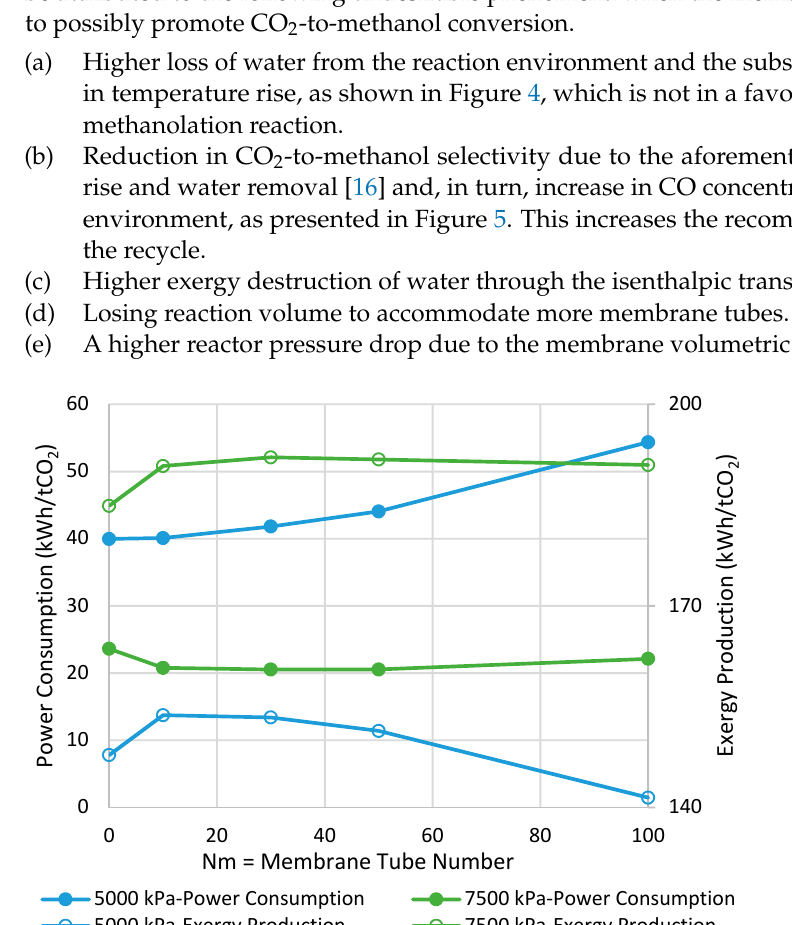
Figure 3. Comparison between adiabatic conventional reactors (CR) and MR-based processes with different membrane tube numbers using power consumption and exergy production (Nm = 0 corresponds to CR).